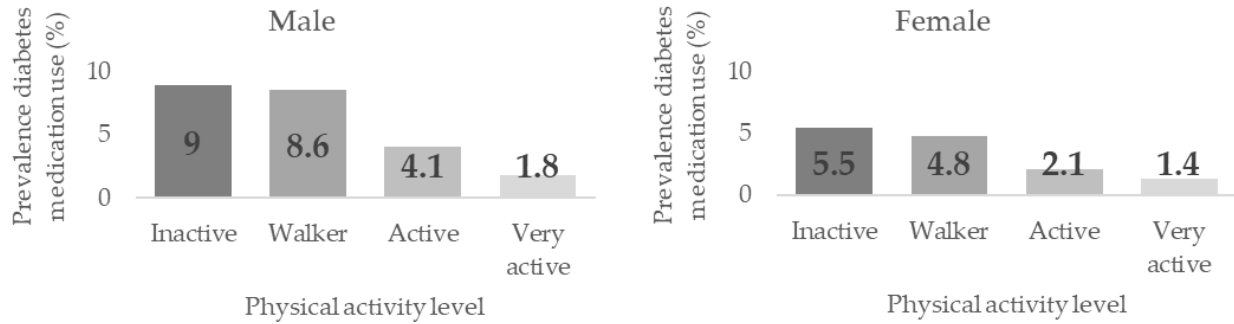
Figure 4. Diabetes Medication Use prevalence according to their Physical Activity Level by sex. Table 5. Diabetes Risk According to the Physical Activity Level.